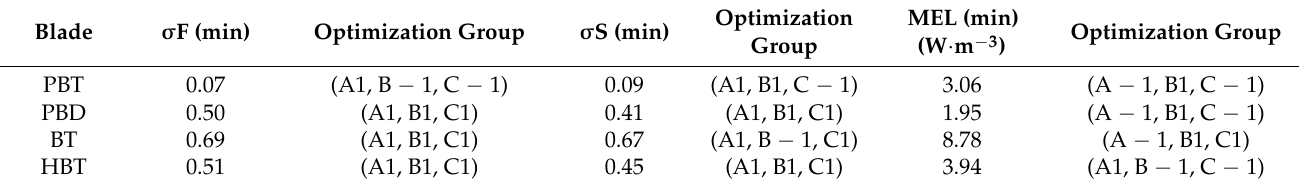
Table 4. Summary table of minimum